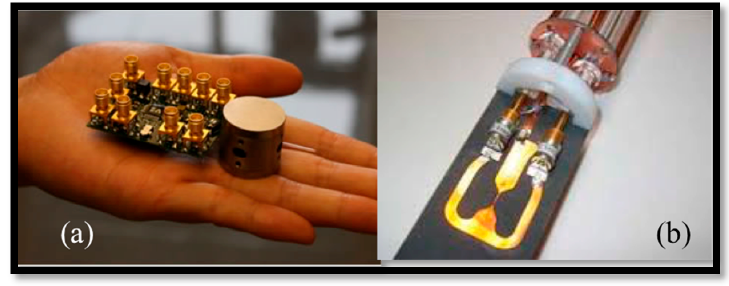
Figure 2. Emerging NMR technologies ( a ) CMOS based palm NMR [6] and ( b ) µ Slot incorporated with NMR probe.